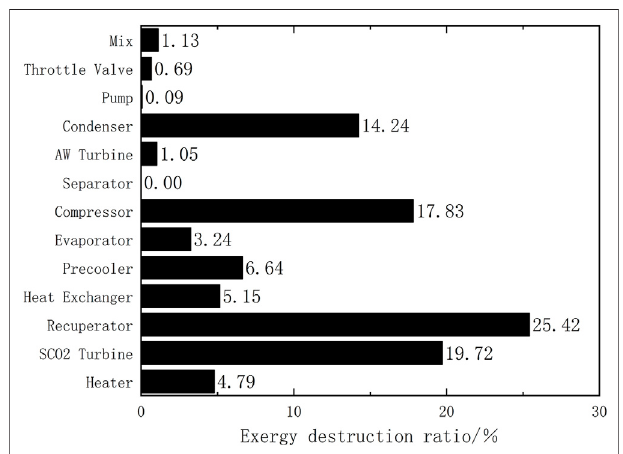
FIGURE 3 | Exergy destruction ratio of equipment in power cycle subsystem.